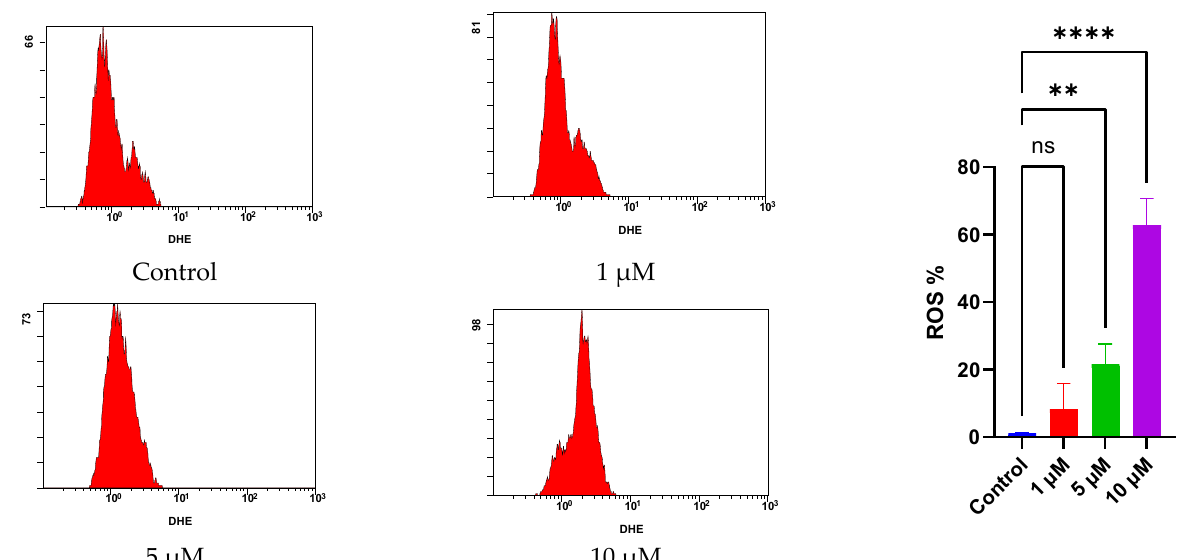
Figure 8. The effect of complex 2 concentrations on ROS levels in MCF-7 cells. The shift of the peaks toward the right shows increasing ROS accumulation in treated cells. The (**) and (****) is significant compare to control.